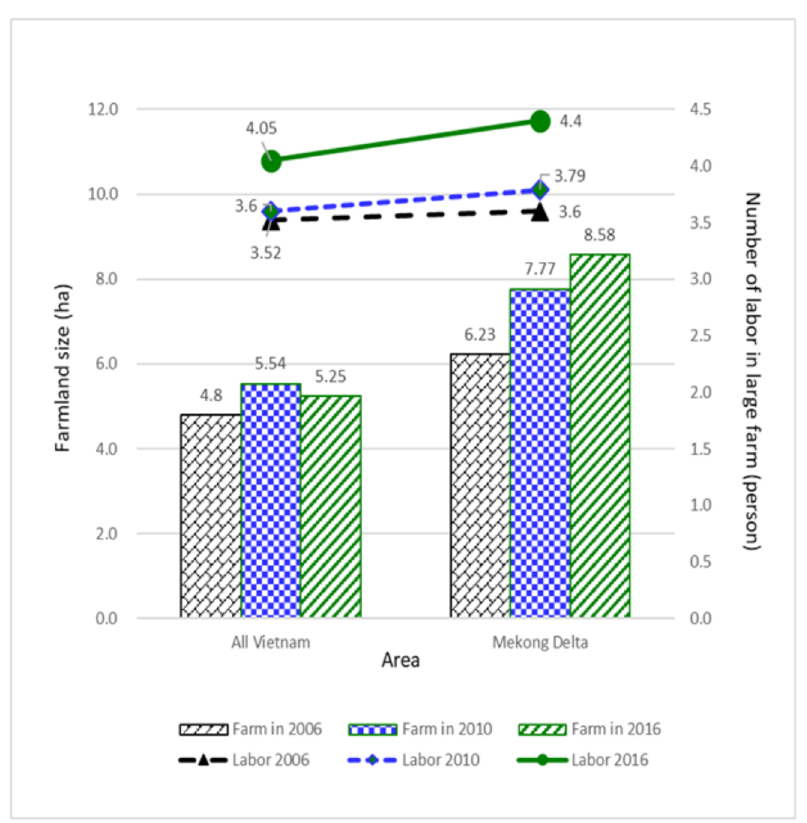
Figure 17. Change of registered large farms from 2006 to 2016. Farmland size / farm and amount of labor / farm in all Vietnam and in the Mekong Delta. Source: created from GSO 2013, 2016